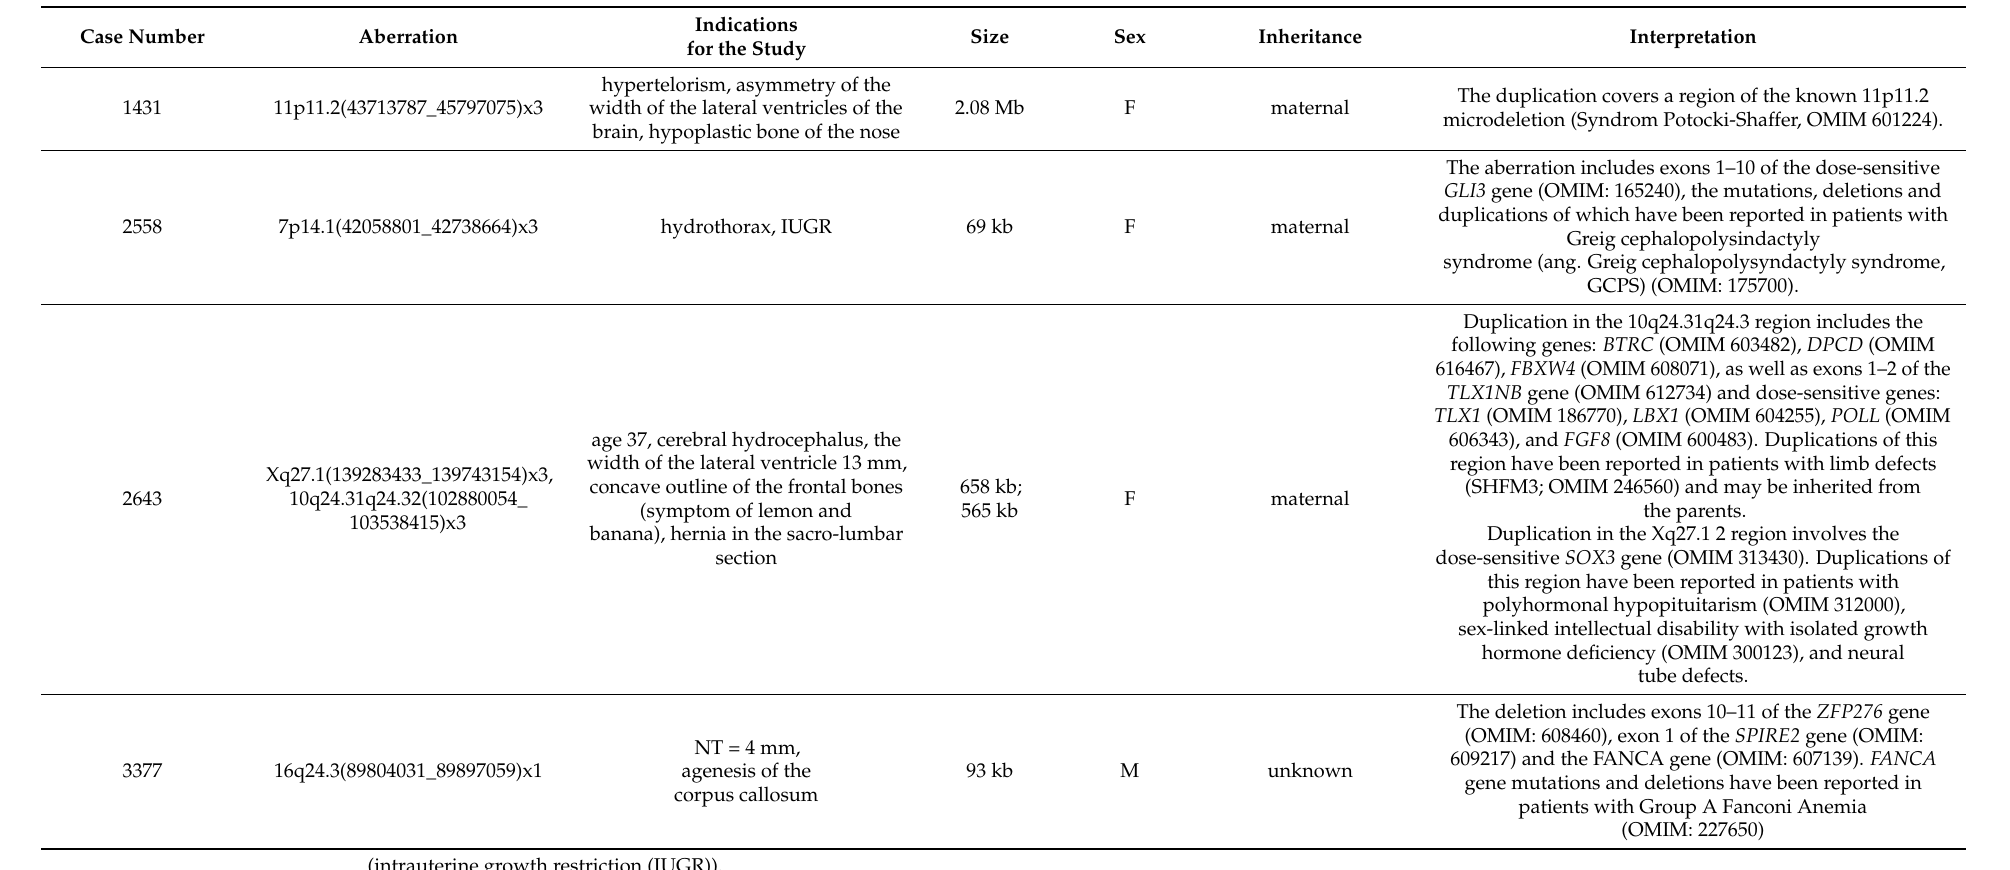
Table 7. Examples of interesting likely pathogenic CNVs which can be correlated with the fetal